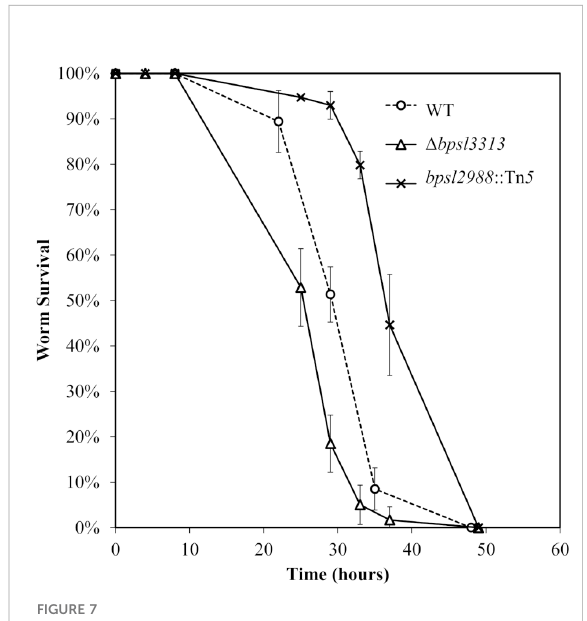
FIGURE 7 Survival of C elegans infected with B. pseudomallei wild type (WT) and mutants. Graph shows the mean ± SD from a representative of three independent assays.